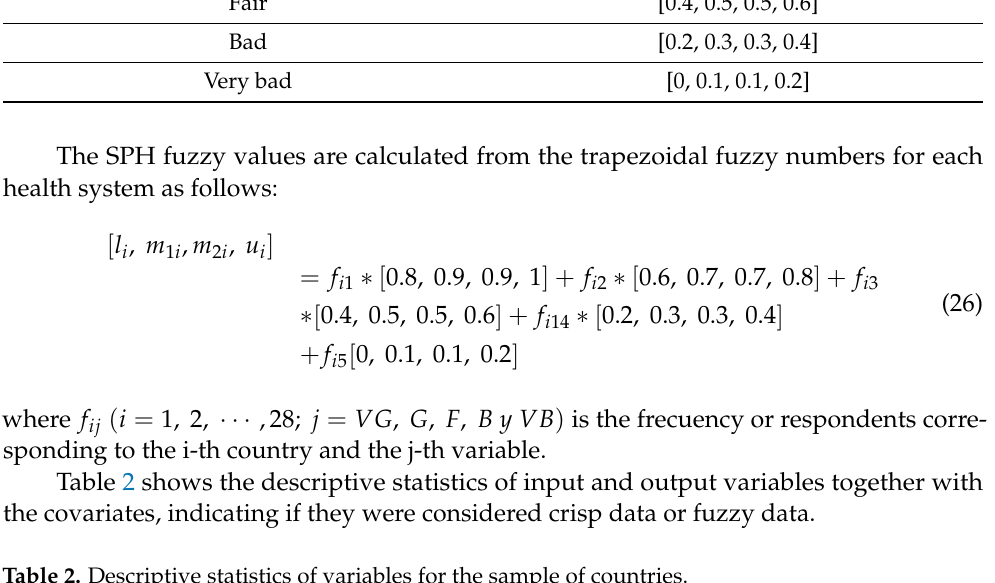
Table 2. Descriptive statistics of variables for the sample of